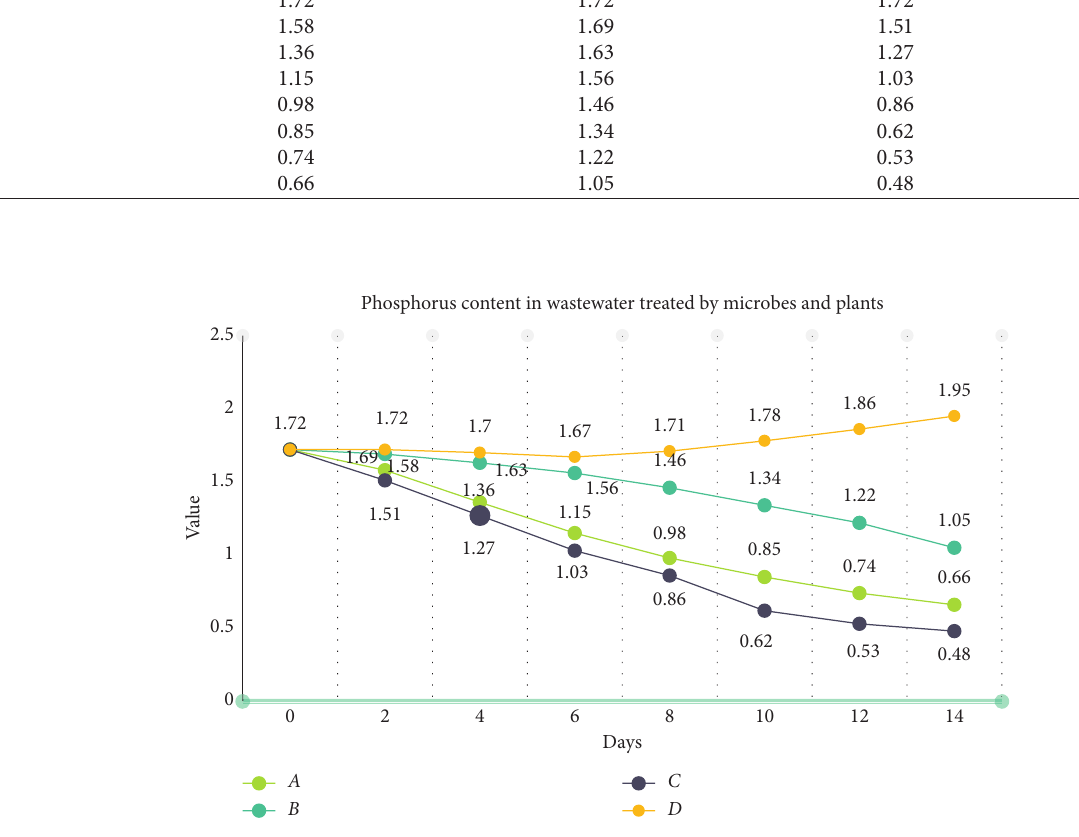
Figure 5: Changes of total phosphorus content in wastewater treated by the microbe